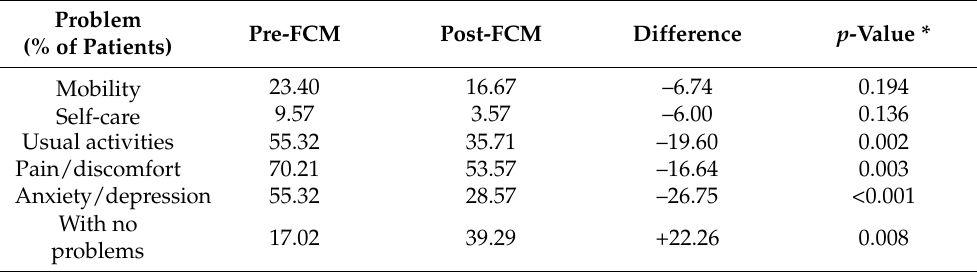
Table 3. EQ-5D descriptive system.